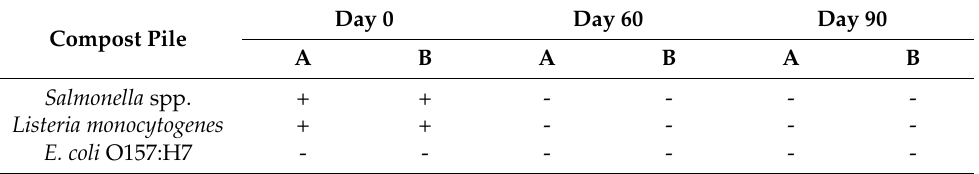
Table 7. Real-time quantitative PCR detection of human pathogens during the composting process. Positive PCR reactions are reported as “+” when triplicate samples from the same composting piles were analyzed and at least one replicate was positive. Negative reactions are reported as “-” (all replicates are negative). Day 0 Day Compost Pile